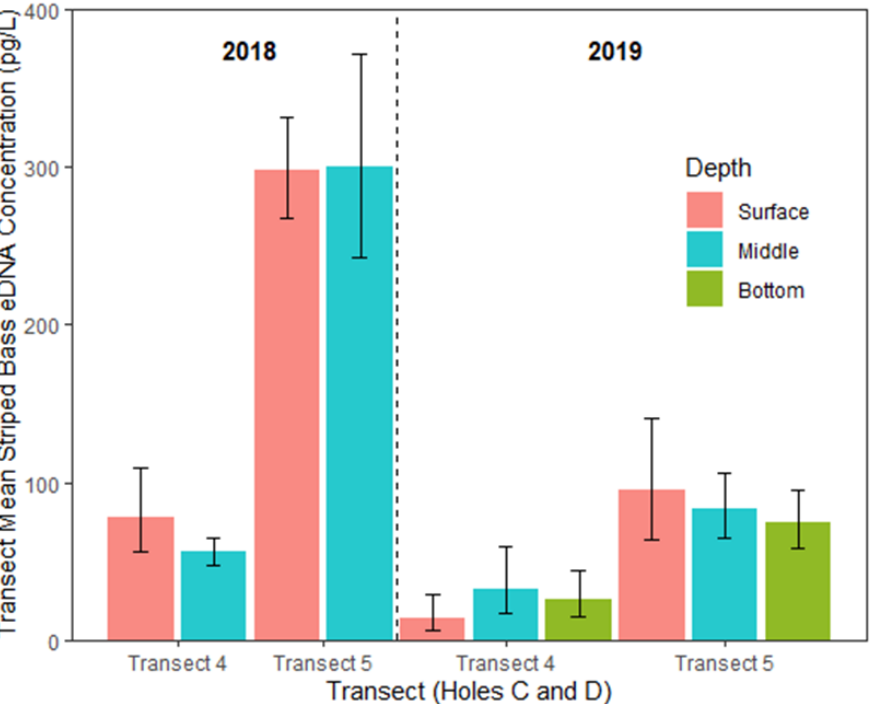
Figure 4. Back-transformed mean striped bass eDNA concentrations (pg/L) ± standard deviation for 2018 and 2019 samples collected at the surface, 3 m depth or 50% off the bottom (Middle), and 20% off the bottom (Bottom) from holes C and D in transect 4 and 5.